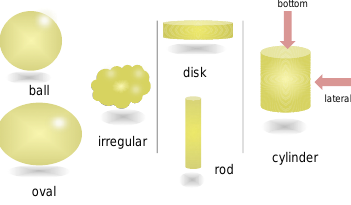
Figure 3. Various shapes of molecules and molecular complexes.